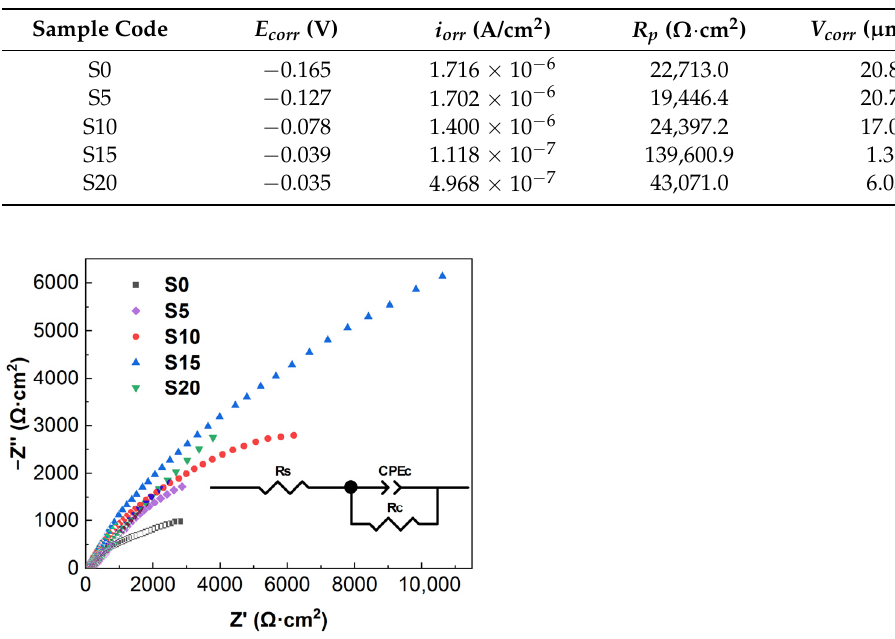
Figure 8. Potentiodynamic polarization curves of all samples. Table 3. Results of potentiodynamic polarization test in 3.5 wt.% NaCl solution.